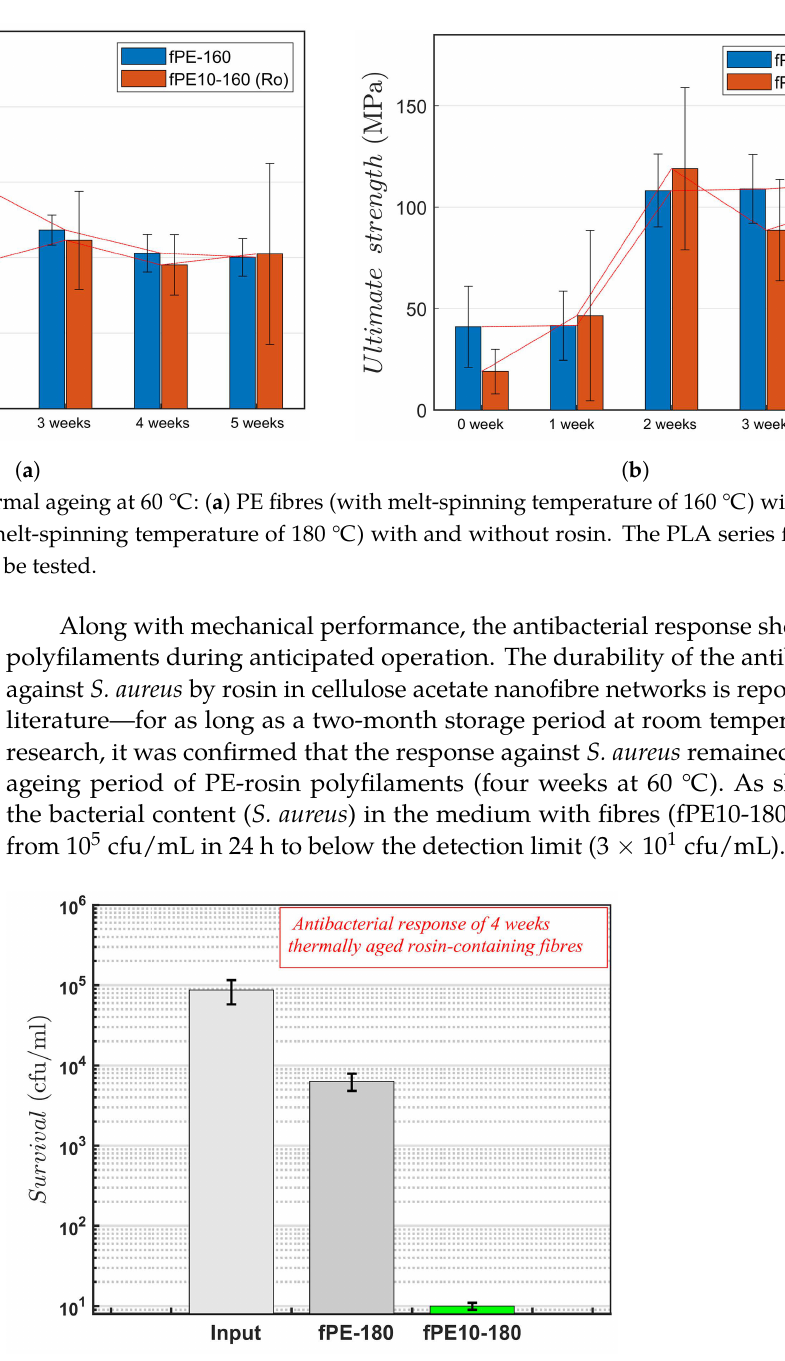
Figure 5. Antibacterial response of melt-spun polyfilaments against S. aureus in liquid (Ringer’s solution, 1/4 strength) after 24 h mixing at room temperature: four weeks thermally aged (60 ℃ ) PE polyfilament fibres with and without rosin. PLA fibres lose their fibrous form at 60 ℃ and can not be tested as polyfilament fibres. The detection limit is 3 × 10 1